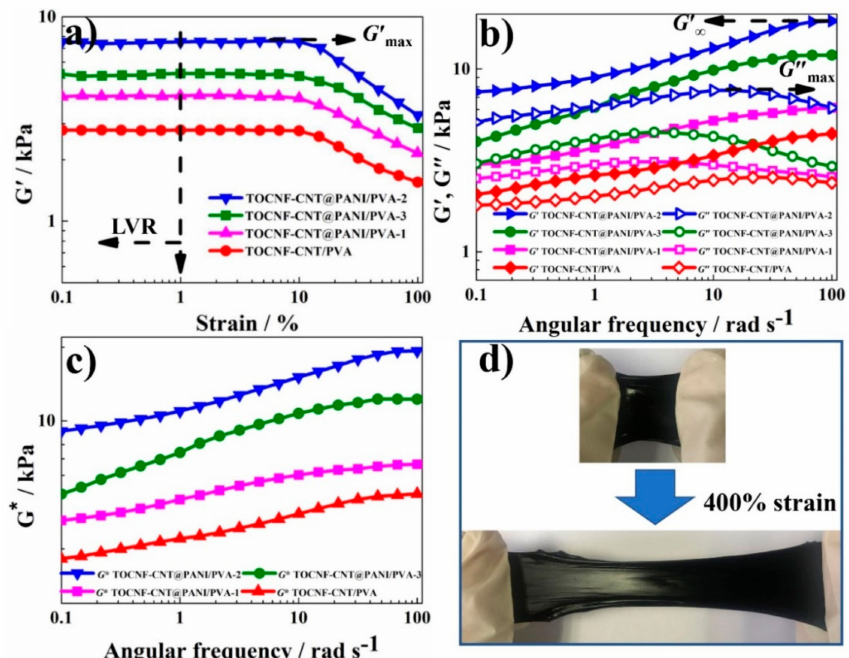
Figure 4. Dynamic viscoelastic properties of hydrogels at 25 ◦ C. ( a ) storage modulus ( G (cid:48) ) curves based on strain ( γ ) at angular frequency ( ω ) = 1 Hz; ( b ) G (cid:48) and loss modulus ( G (cid:48)(cid:48) ) curves based on ω at γ = 1%; ( c ) complex modulus ( G *) curves based on ω at γ = 1%; ( d ) stretching demonstration